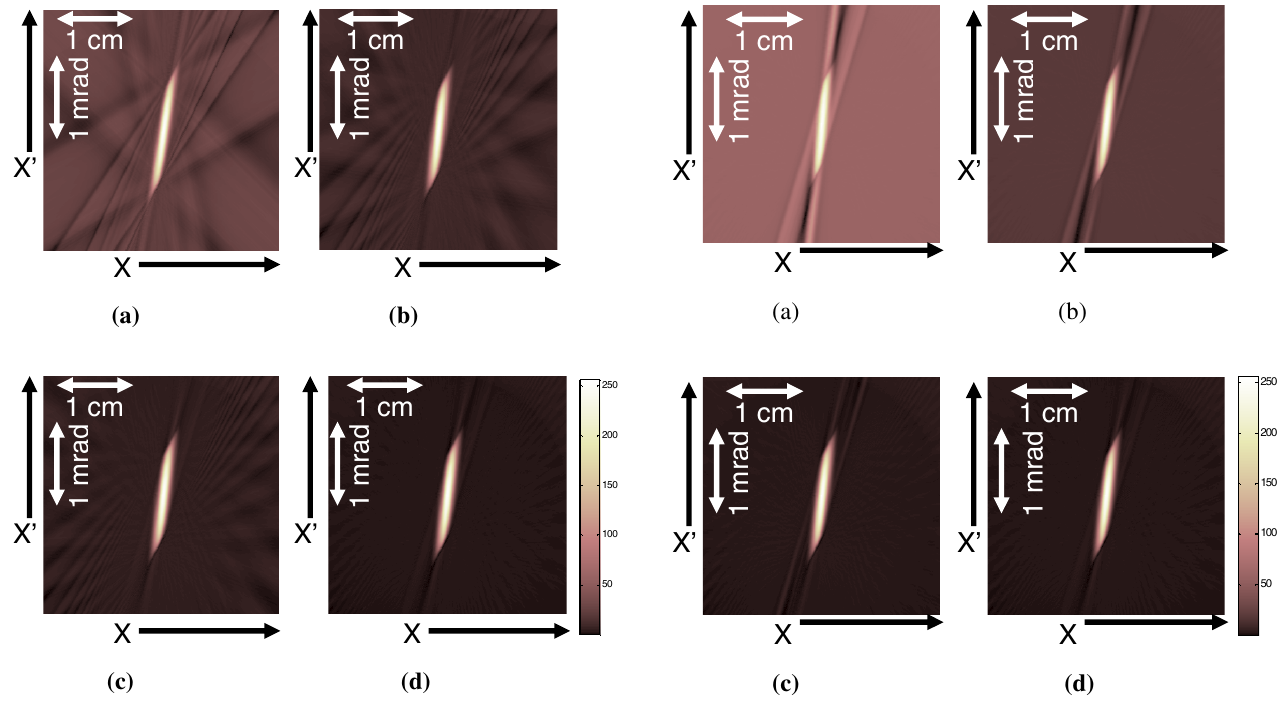
FIG. 2. (Color) X 0 X tomographic recovery of the 0.6 mA (pencil beam) using a different number of projections. (a) 30 projec- tions, (b) 70 projections, (c) 105 projections, (d) 210 projections.